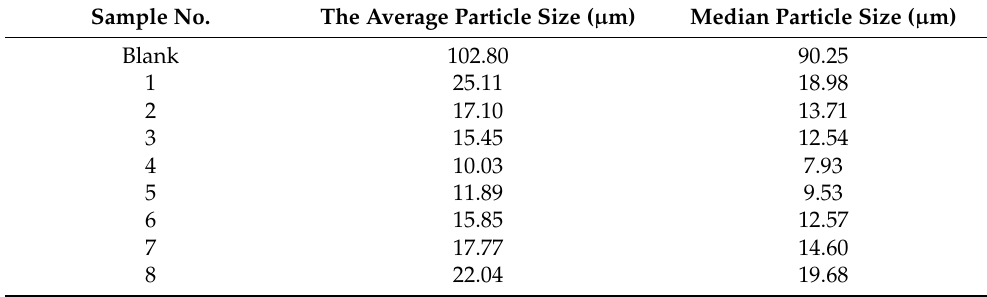
Table 4. Average and median particle sizes of graphite before and after modification with CTAC. Sample No.